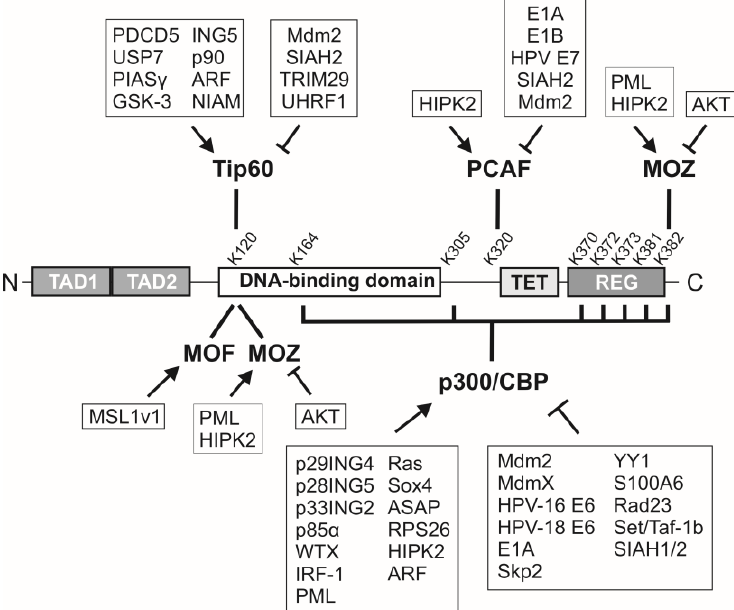
Figure 3. p53 acetyltransferases are targeted by multiple proteins that regulate their function. Schematic of p53 highlighting its acetylation by six different histone acetyltransferases, p300/CBP, PCAF, Tip60, MOF, and MOZ. The ability of these acetyltransferases to regulate p53 is influenced both positively (arrows) and negatively (perpendicular bars) by many types of proteins, including the indicated viral proteins, ubiquitin ligases, kinases, and other cellular factors. TAD, transactivation domain; TET, tetramerization domain, REG, regulatory